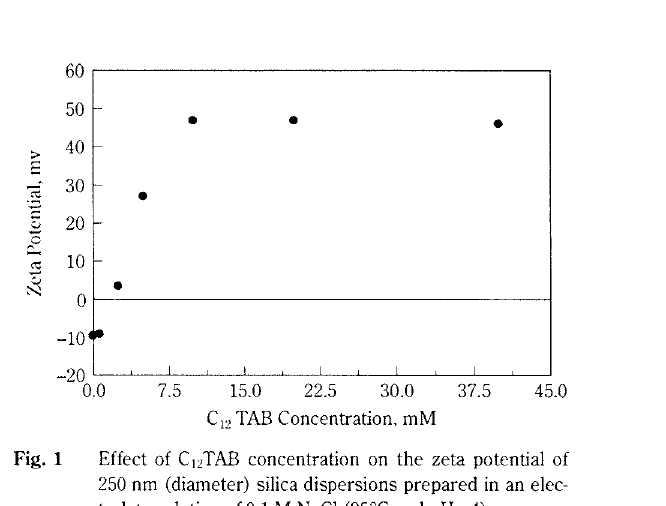
Fig. 1 Effect of C 12 TAB concentration on the zeta potential of 250 nm (diameter) silica dispersions prepared in an elec trolyte solution of0.1 M NaCI (25°C and